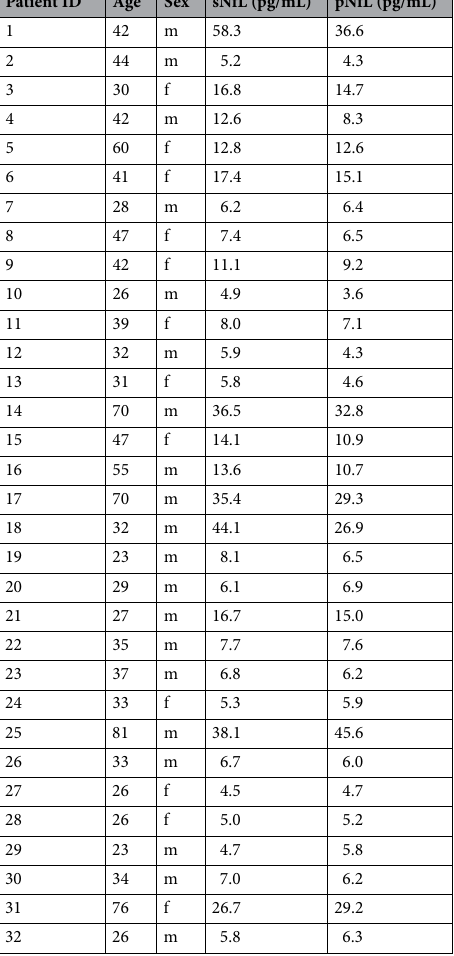
Table 1. Patient characteristics. f female, m male, pNfL plasma neurofilament light chain, sNfL serum neurofilament light